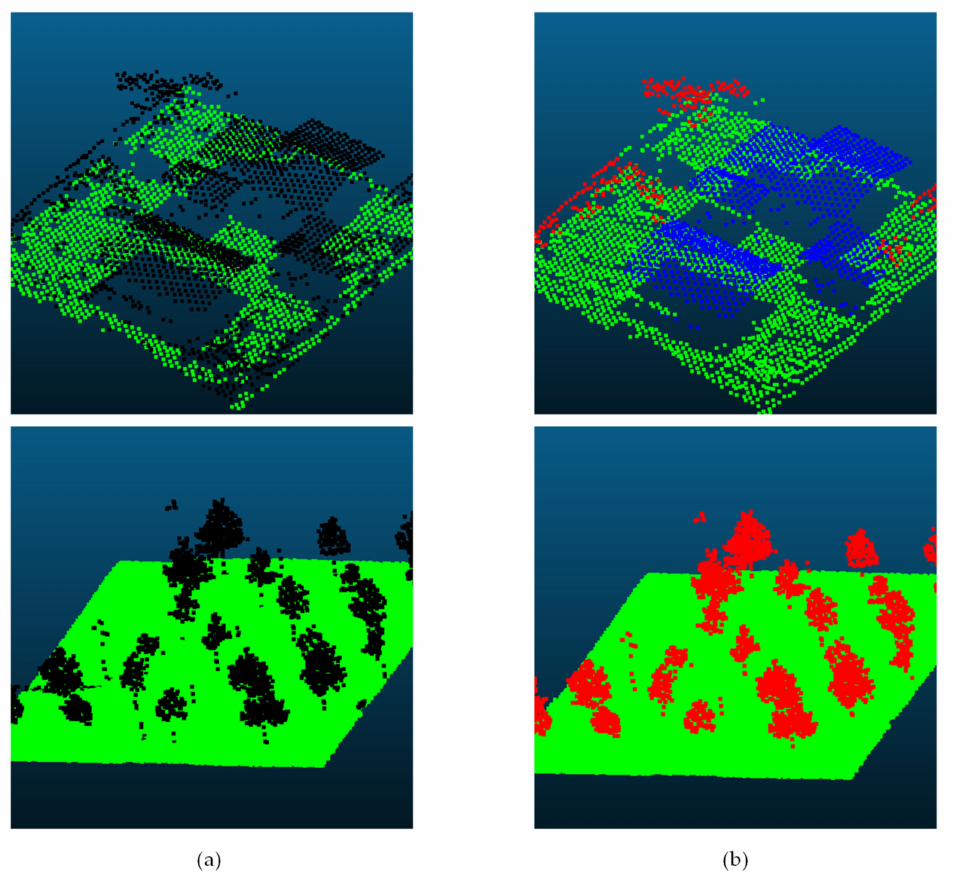
Figure 12. ( a ) The point-in-polygon labels on training area; ( b ) Prediction result by our framework in the training area. Building, navy blue; tree, red; and terrain,